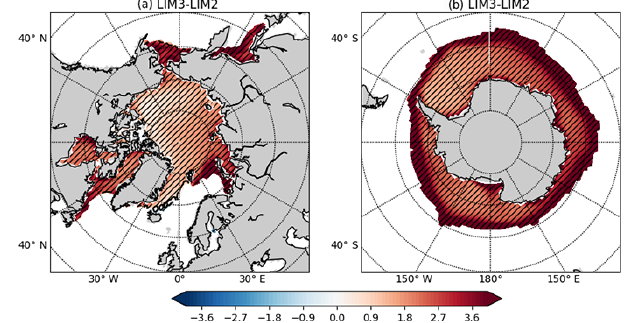
Figure 4. The sea-ice salinity difference (in ppm) between LIM3 and LIM2 (a) in the Arctic in March and (b) in the Antarctic in September. Note that the LIM2 sea-ice salinity is constant at 4ppm. Hatching indicates regions with statistically significant differences between LIM3 and LIM2 at the 5% level based on unequal vari- ances t